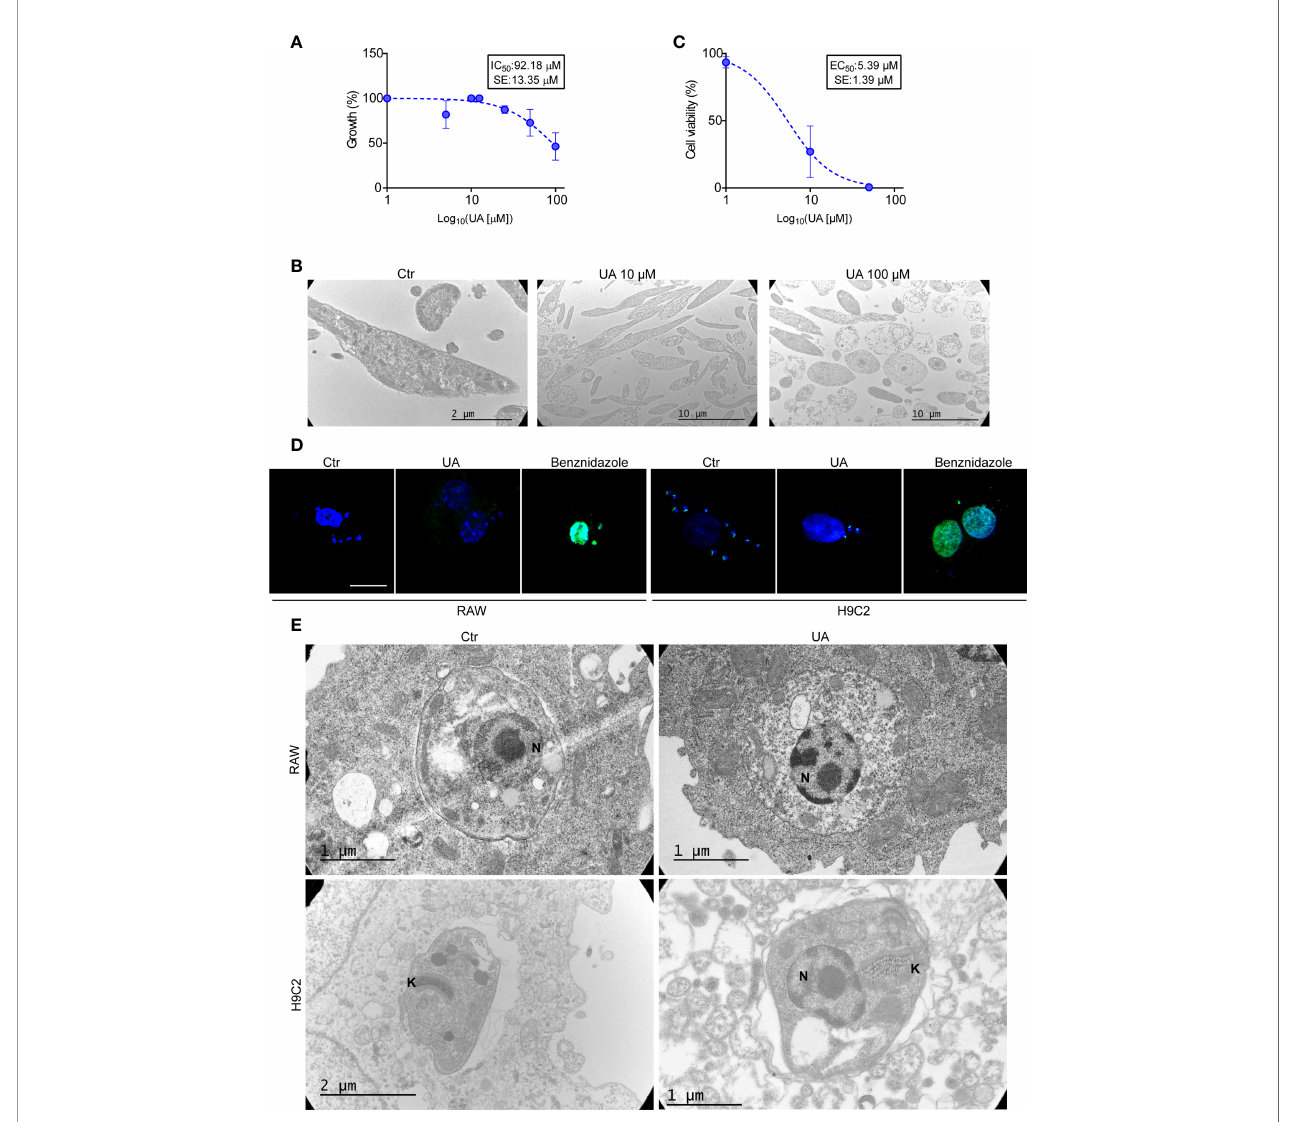
FIGURE 4 | Direct action of UA on different stages of Trypanosoma cruzi . (A) Epimastigotes were grown at different concentrations of UA for 24 h at 28°C. The graph shows the quanti fi cation of IC50. (B) Transmission electron microscopy images of epimastigotes treated under different conditions for 24 h. (C) The trypomastigotes were treated at different concentrations of UA for 24 h at 4°C. The graph shows the quanti fi cation of the EC50. (D) RAW macrophages and H9C2 cells were infected with T. cruzi trypomastigotes Y strain (MOI = 10) for 24 h and then treated for an additional 24 h under the different conditions. Subsequently, we evaluated apoptosis of the amastigotes and/or host cells using the TUNEL assay. White arrows point to amastigotes. (E) RAW macrophages and H9C2 cells were infected with T. cruzi trypomastigotes Y strain (MOI = 10) for 24 h and then treated for an additional 24 h under the different conditions. Transmission electron microscopy images show amastigotes inside the host cell. UA, ursolic acid; MOI, multiplicity of